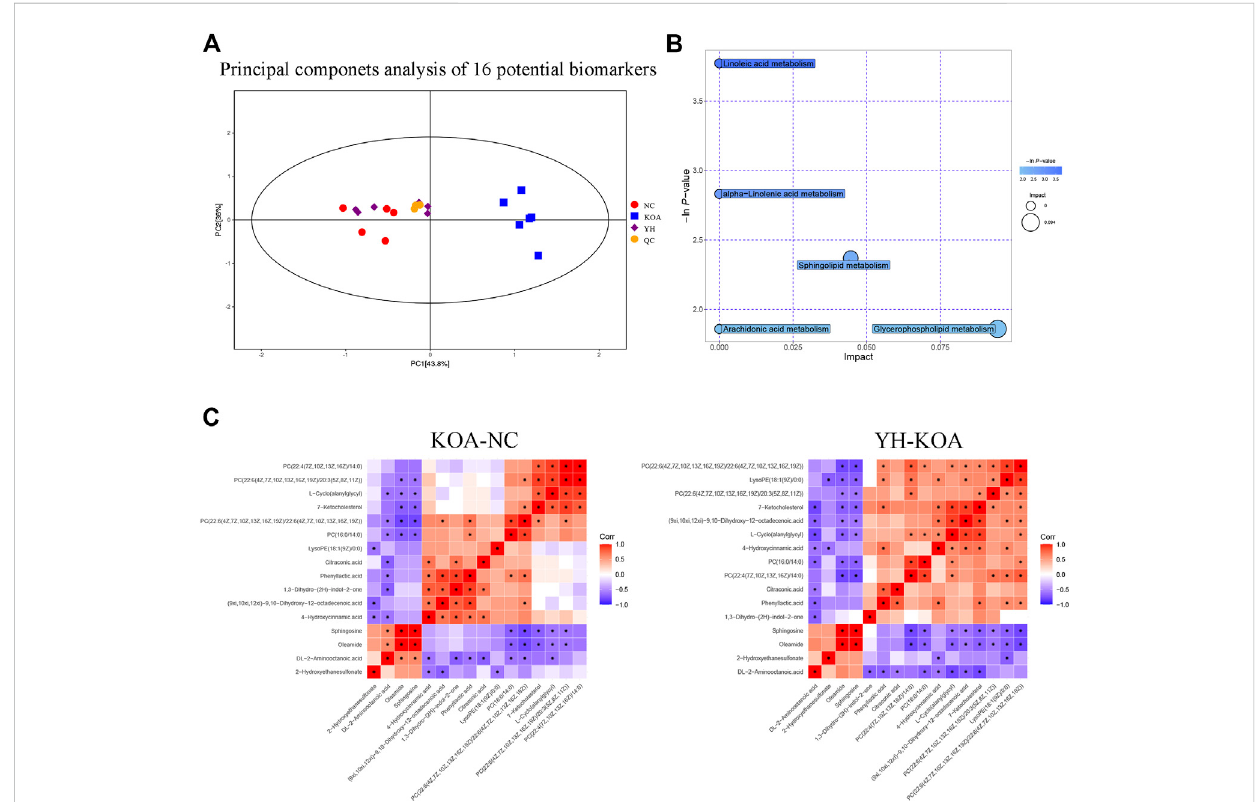
Metabolic pro fi ling of 16 potential biomarkers. (A) Principal components analysis score plot of 16 differential metabolites. (B) Metabolic pathway bubble plot of 16 differential metabolites. (C) Heatmap of correlation analysis. The horizontal and vertical coordinates in the fi gure represent the contrasting differential metabolites. Red represents a positive correlation, blue represents a negative correlation, and the darker the color, the stronger the correlation. Signi fi cant correlations are marked with an asterisk (*).